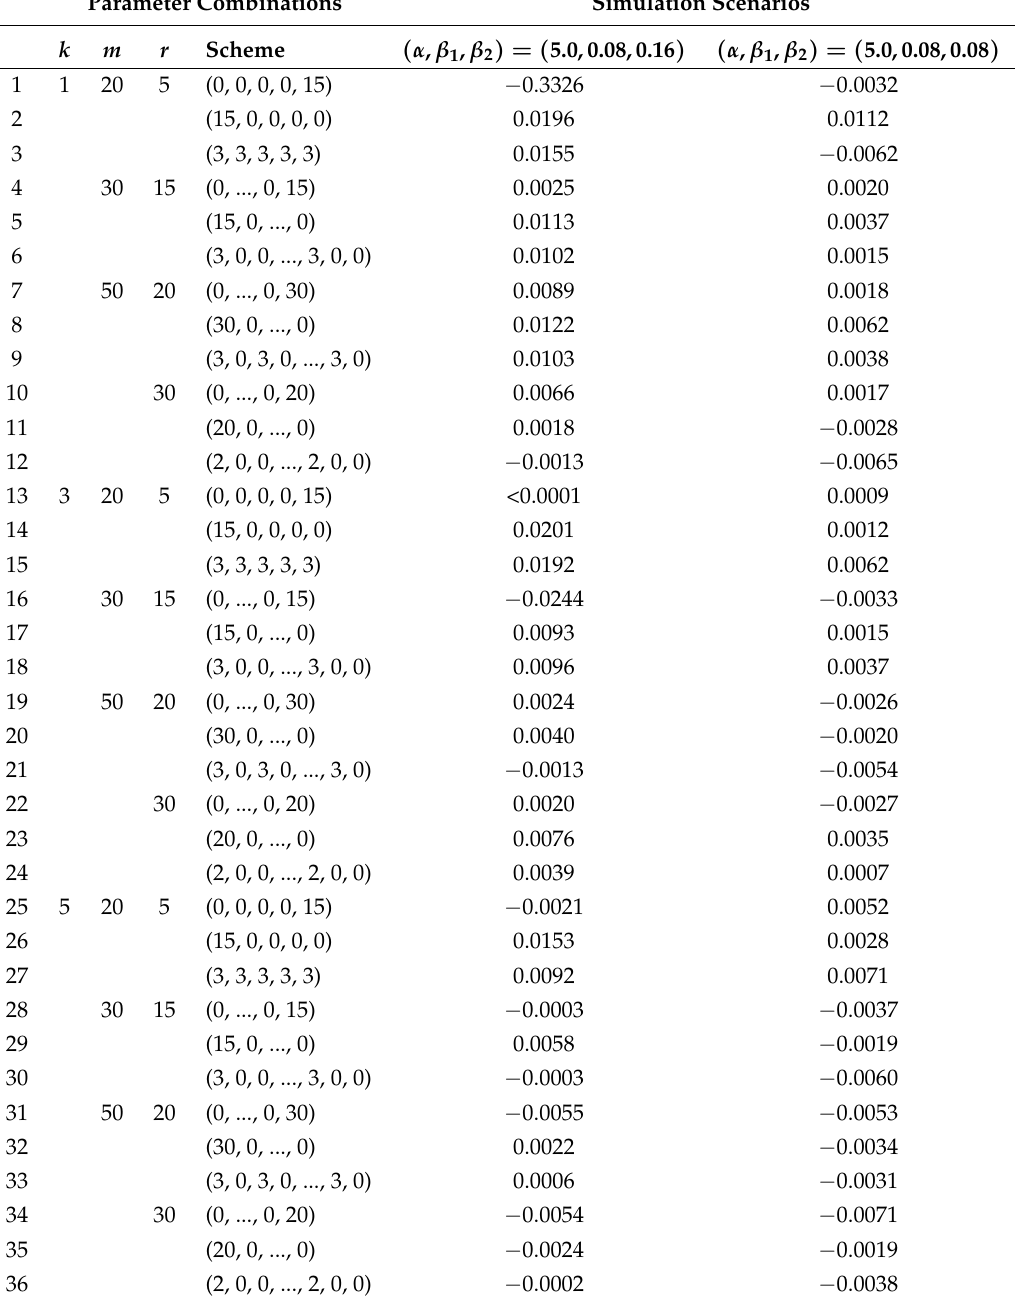
Table 1. The bias of ˆ δ SE under different Burr type XII